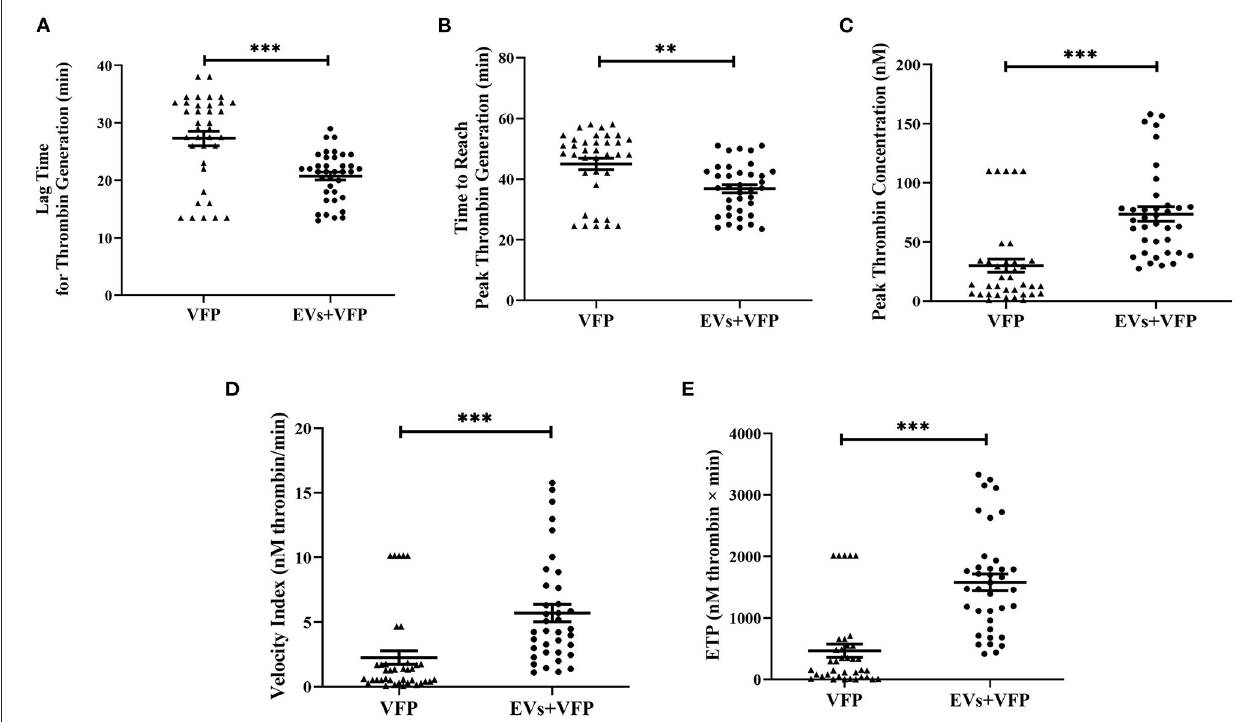
FIGURE 2 | Thrombogenicity of circulating EVs in activating TF-dependent thrombin generation. (A) Data are mean ± SEM, triangles represent the TF-dependent thrombin generation exhibited in VFP of each individual and dots represent the TF-dependent thrombin generation exhibited in VFP with the addition of circulating EVs of each individual. Addition of circulating EVs into VFP significantly shortened the lag time for thrombin generation and (B) the time to reach peak thrombin generation (C) significantly increased peak thrombin concentration; (D) velocity index and (E) ETP compared to VFP alone. ** p < 0.01 and *** p < 0.001. ETP, endogenous thrombin potential; EVs, extracellular vesicles; VFP, vesicle-free